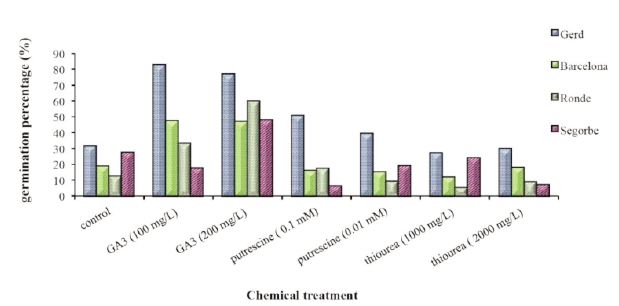
fig. 1 - effect of chemical treatments and cultivars on seed ger- mination percentage of hazelnut cultivars.